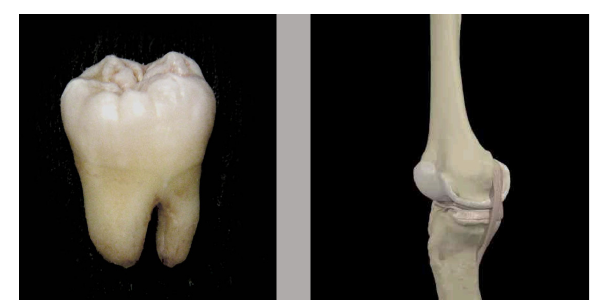
FIGURE 1 | An example of a picture of a tooth (Left) and paired picture (Right) used in the dot-probe